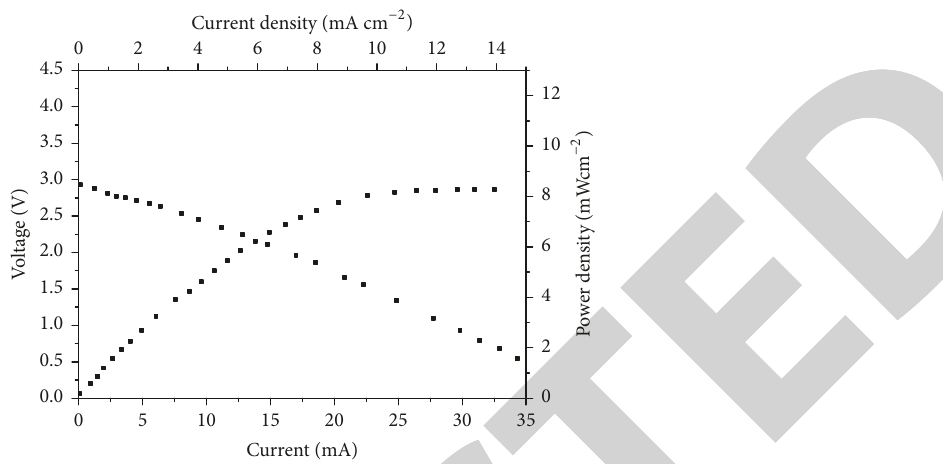
were evaluated for 35PVA/35PVP : 30MgCl 2 ⋅ 6H 2 O polymer electrolyte